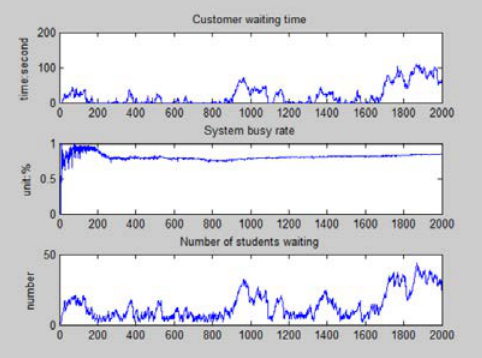
Fig. 3. Student waiting time, system busy rate, waiting number. According to the same idea and method, and according to the changes of student flow and window service level in different periods, the dynamic simulation can get the best number of windows in different periods and different student flows to adapt to various changes and effectively improve service